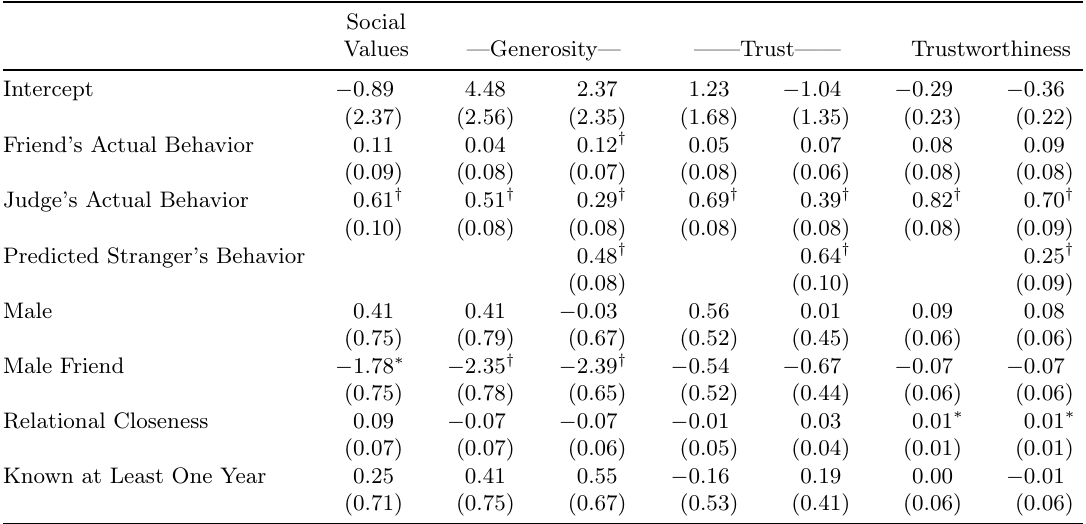
Male Friend Relational